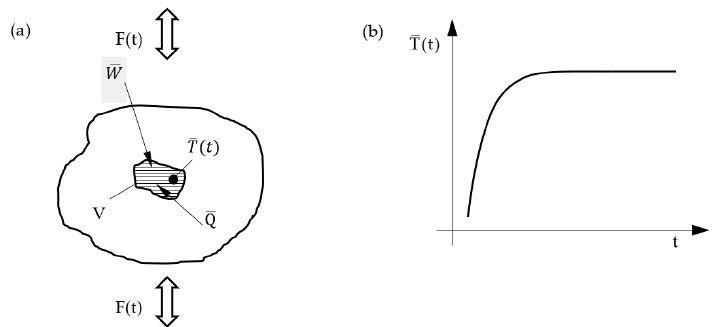
Figure 1. ( a ) Energy balance for a material undergoing fatigue loadings and ( b ) evolution of the average temperature per cycle.